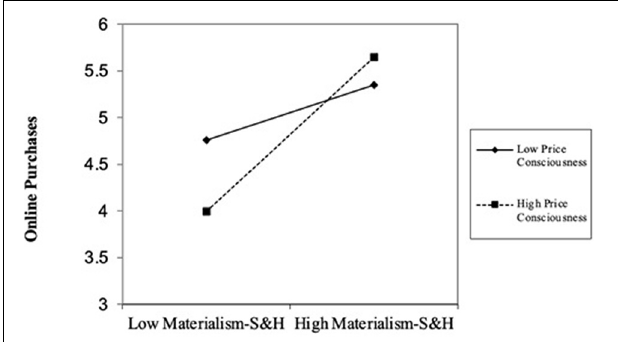
FIGURE 2 | Interaction of materialism-S&H and price consciousness on online